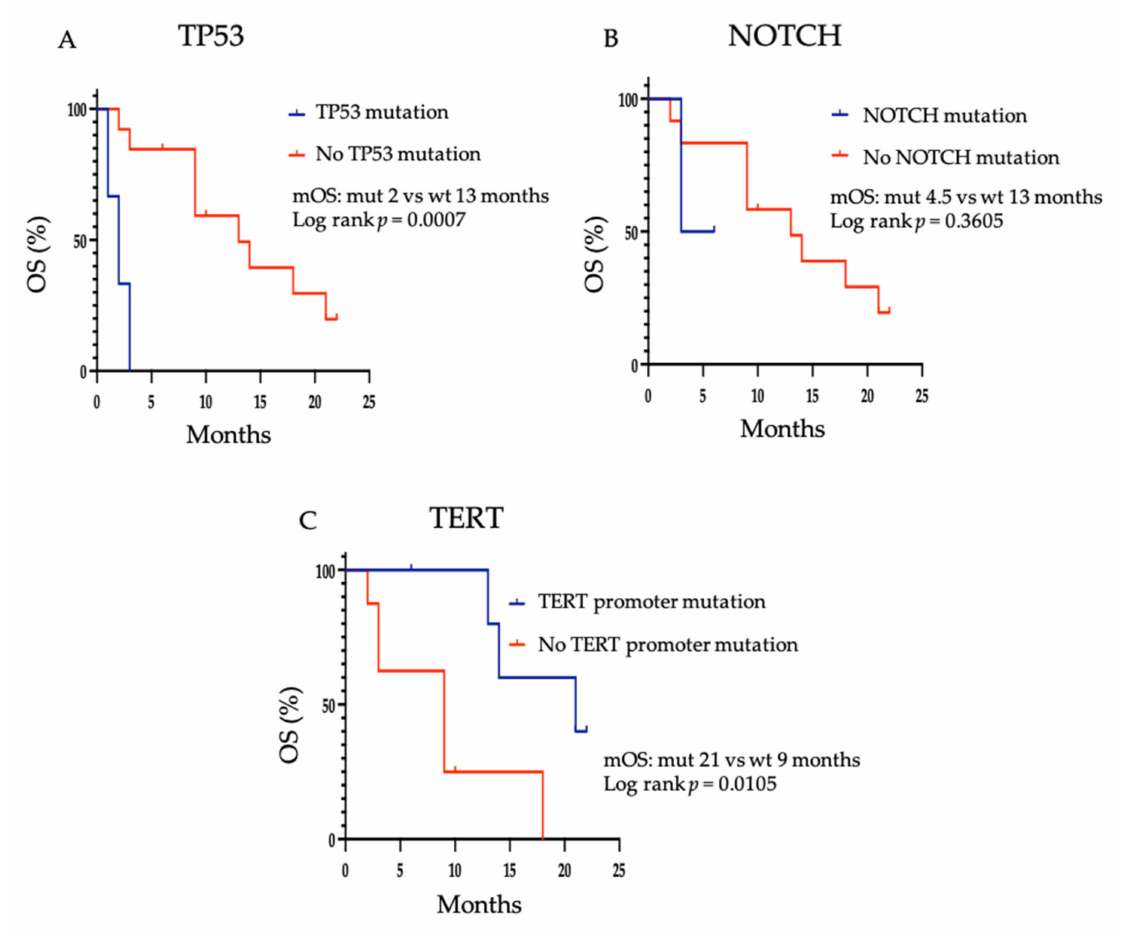
Figure 4. Kaplan–Meier estimate for overall survival in patients with or without ( A ) TP53 mutation, ( B ) NOTCH1 mutation and ( C ) TERT mutation. mOS = median overall survival; mut = mutant; wt = wild